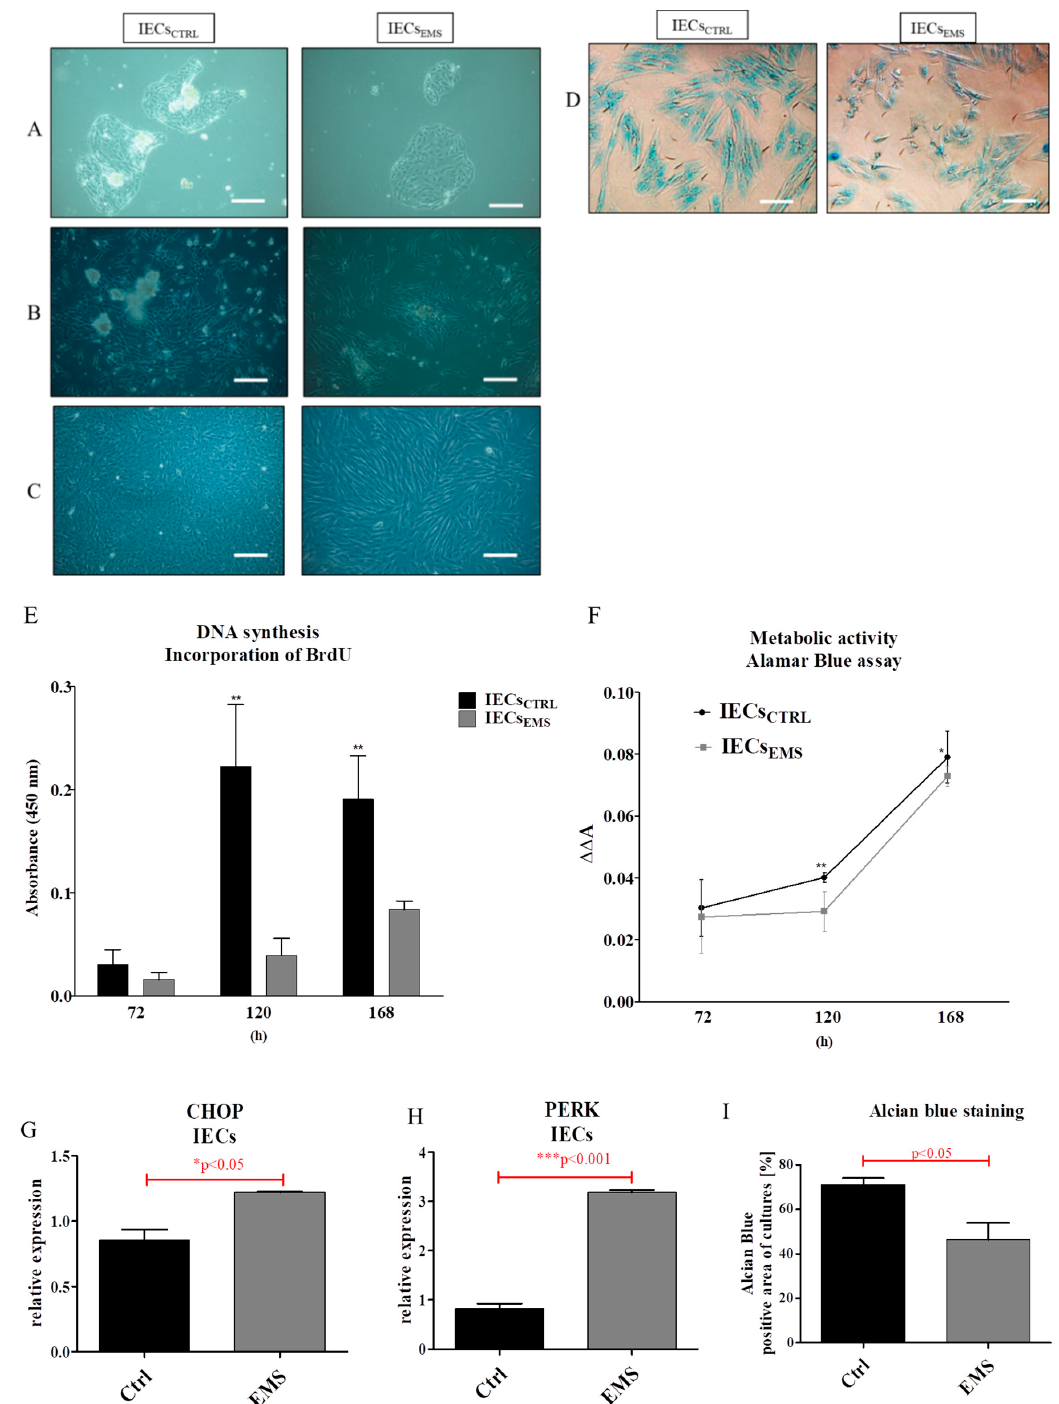
Figure 2. Morphology and proliferation of IECs in subsequent cultures (P1). The cultures were monitored after 72 ( A ), 120 ( B ) and 168 ( C ) h after passaging and stained with Alcian Blue to confirm mucin secretion ( D ). DNA synthesis was established using BrdU assay ( E ) and cell number during the cultivation was assessed with Alamar Blue ( F ). Moreover, using RT-PCT we evaluated the expression of ER stress related genes including CHOP ( G ) and PERK ( H ). Additionally, Alcian Blue staining quantification was performed using ImageJ, which revealed decreased mucin formation in IECs EMS (I). Scale bars: light microscope 100 µ m. Results expressed as mean ± S.D. * p < 0.05; ** p < 0.01; *** p < 0.001.